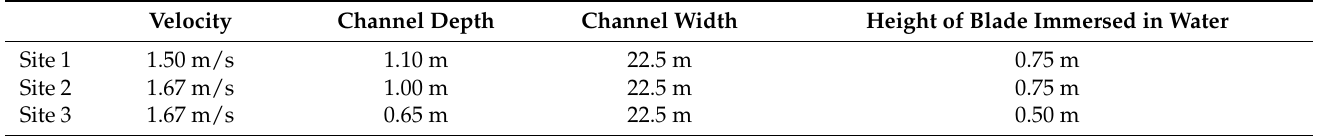
Height of Blade